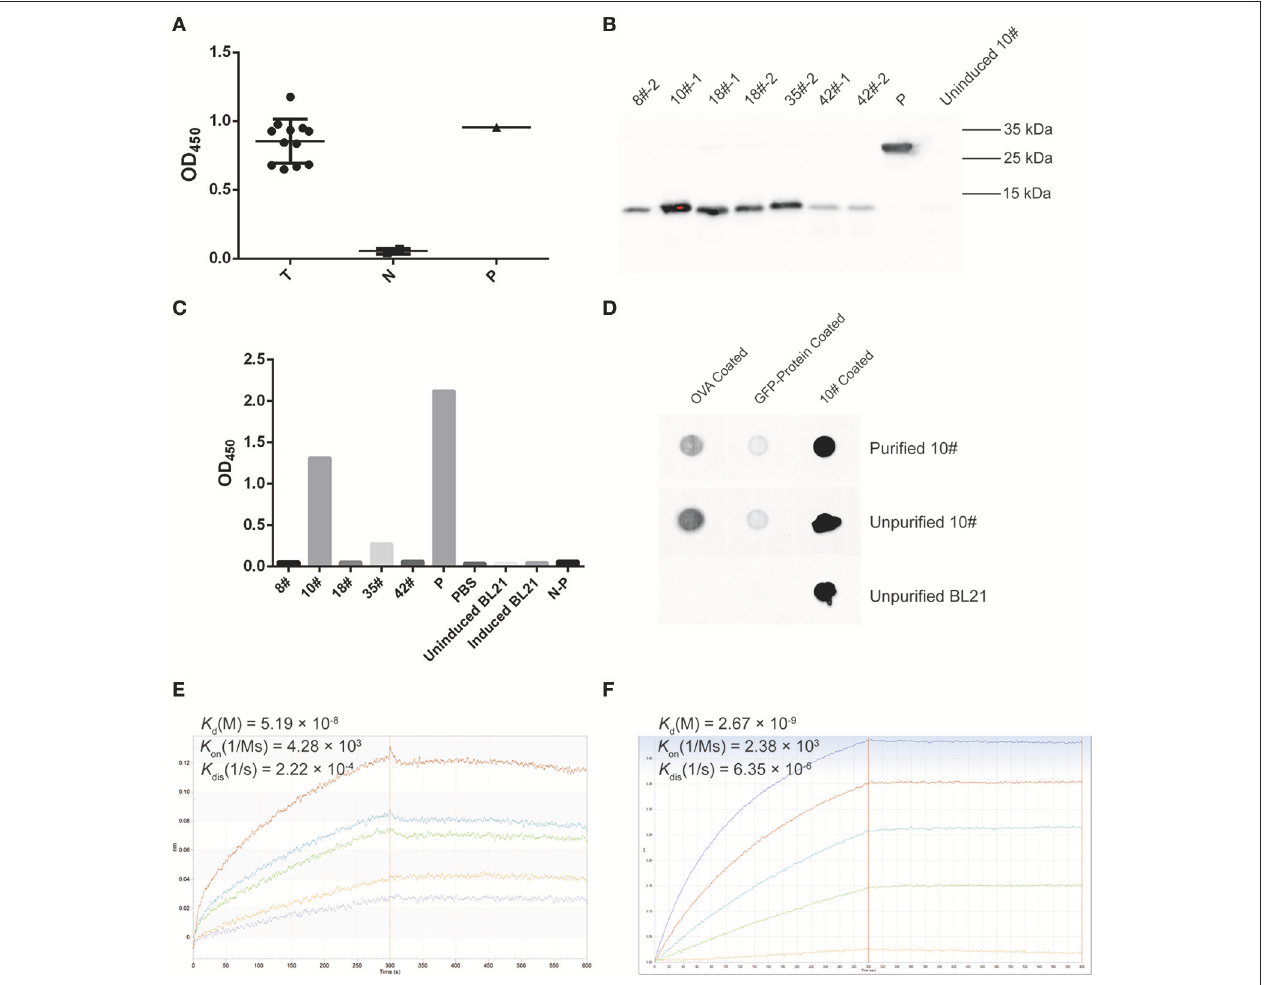
FIGURE 7 | OVA-specific nano-body screening and affinity evaluation. (A) The binding capability of OVA-specific phages was evaluated by phage ELISA using an anti-M13-HRP antibody. A well coated with M13 was used as a positive control (P), an irrelevant protein containing the GFP-tag, PBS, and M13 served as negative controls (N). Twelve screened phages were tested as samples (T). The OD 450 values are indicated. (B) Western blotting for OVA-specific nano-bodies. A His6-tagged protein was used as a control (P), and the un-induced culture product of #10 clone was used as a negative control. (C) The binding of expressed OVA-specific nano-bodies was evaluated by ELISA. A well coated with His6-tagged protein was used as a positive control (P), and an irrelevant protein containing the GFP-tag (N-P), PBS, IPTG-induced and uninduced BL21 culture product were used as negative controls. The OD 450 values are indicated. (D) Dot blotting of expressed OVA-specific nano-body #10. An irrelevant protein containing the GFP-tag was used as a control. (E) Binding kinetics of the #10 nano-body (20 µ g/ml) to OVA (2.22, 1.11, 0.56, 0.28, 0.14 µ M) were detected using the Octet-RED instrument. The equilibrium dissociation constant ( K d ) is indicated. (F) Binding kinetics of a commercial anti-ovalbumin antibody (5 µ g/ml) to OVA (3.84, 1.92, 0.96, 0.48, 0.24 µ M) were detected using the Octet-RED